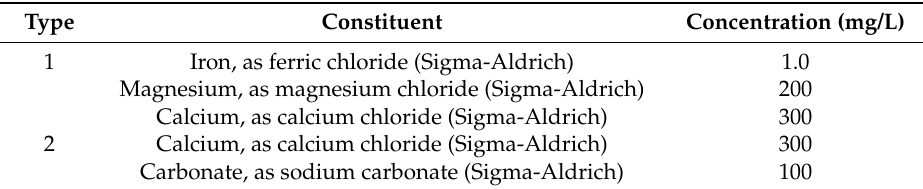
Table 1. Initial concentration of constituents in feed